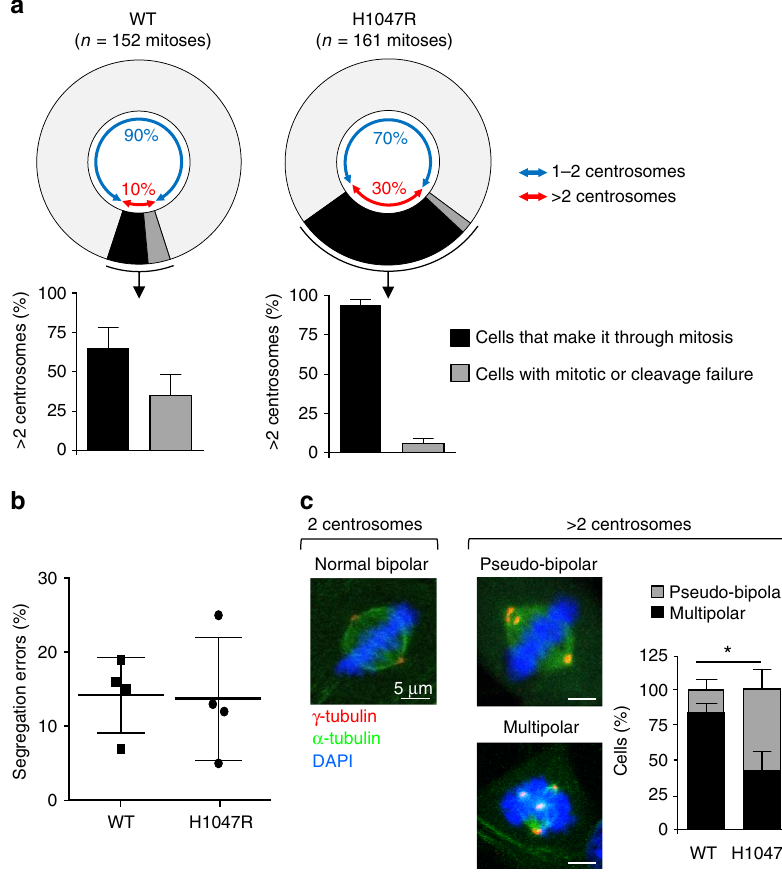
Fig. 5 Ef fi cient clustering of extra centrosomes and lack of chromosomes segregation errors early upon p110 α H1047R expression. a Quanti fi cation of the number of cells with centrosome ampli fi cation that either make it through mitosis or experience mitotic slippage or cytokinesis failure. In total, 152 WT cells (50, 48 and 54 cells from 3 independent WT MEFs) and 161 Pik3ca H1047R cells (50, 61 and 50 cells from 3 independent Pik3ca H1047R MEFs) with centrosome ampli fi cation entering mitosis were analysed; values = mean ± SD). b Frequency of segregation errors occurring in anaphase of Pik3ca WT ; Flpe- ER T2 and Pik3ca H1047R+neo ; Flpe-ER T2 MEFs, 3 days after treatment with 4-OHT. A total of 103 WT cells from 3 independent WT MEFs (33, 32 and 38); and 101 Pik3ca H1047R cells (38, 39 and 24 from 3 independent Pik3ca H1047R MEFs) in anaphase were analyzed for the presence of chromosome segregation errors. Individual values are plotted. c Representative immuno fl uorescence images of mitotic spindle conformations observed in Pik3ca WT ; Flpe-ER T2 and Pik3ca H1047R+neo ; Flpe-ER T2 MEFs, 3 days after treatment with 4-OHT and quanti fi cation of the incidence of pseudo-bipolar and multipolar spindles in metaphases with > 2 centrosomes. 74 WT cells (29, 30 and 15 cells from three independent WT MEFs) and 83 Pik3ca H1047R cells (30, 27 and 26 cells from 3 independent Pik3ca H1047R MEFs) with centrosome ampli fi cation in prometaphase/metaphase were analyzed (values = mean ± SD). Statistically signi fi cant differences are indicated by *( P < 0.05), as determined by non-parametric Mann – Whitney t test